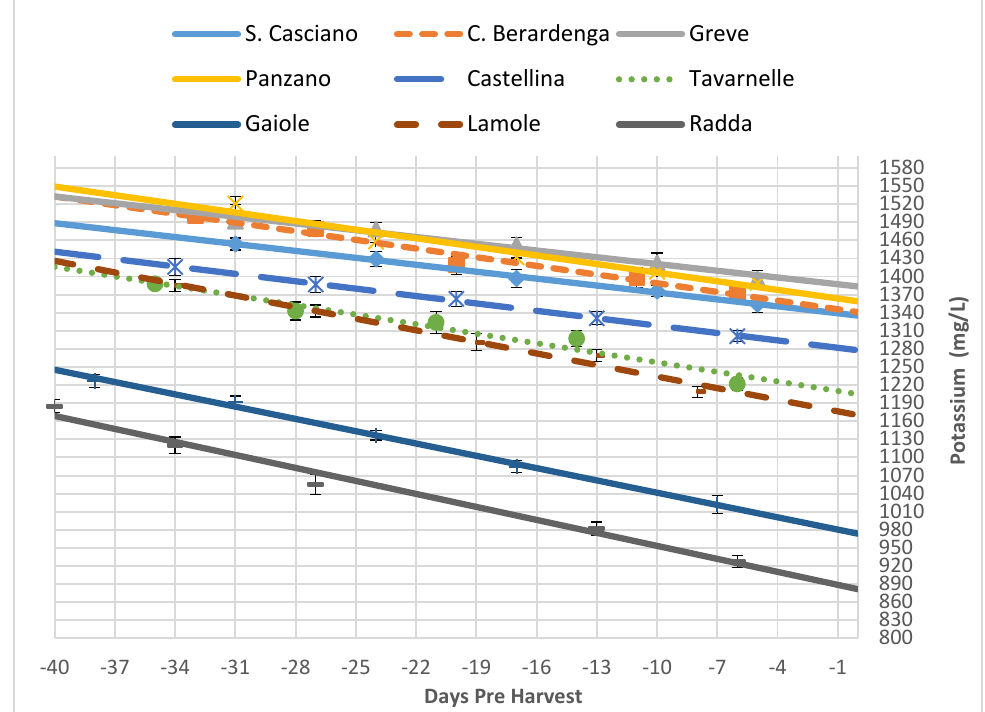
Figure 6. Trends of the potassium in all the analysed vineyards as a function of time (expressed as negative days before the harvest). Each analytical point is reported with its 68% C.L. interval. Table 9. Calculated values of the functional parameters, intercept, slope and R 2 of the potassium inside the grapes coming from the different vineyards.